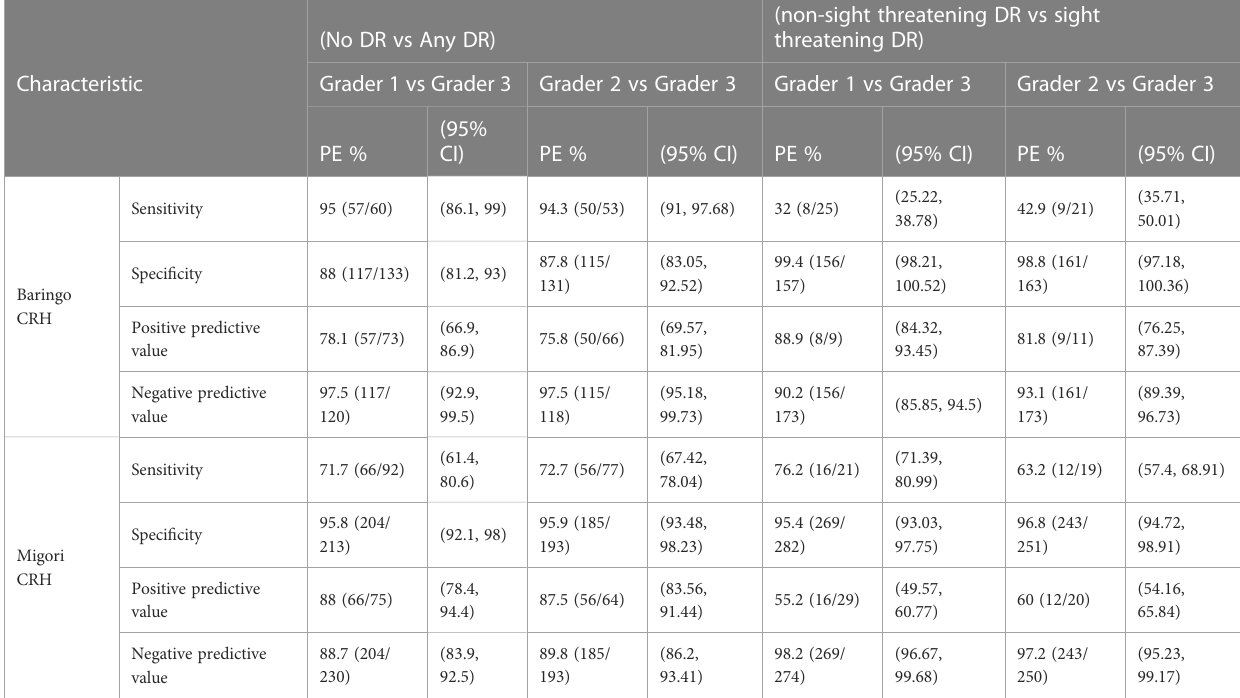
TABLE 4 Sensitivity and Speci fi city segregated by grader level and County.